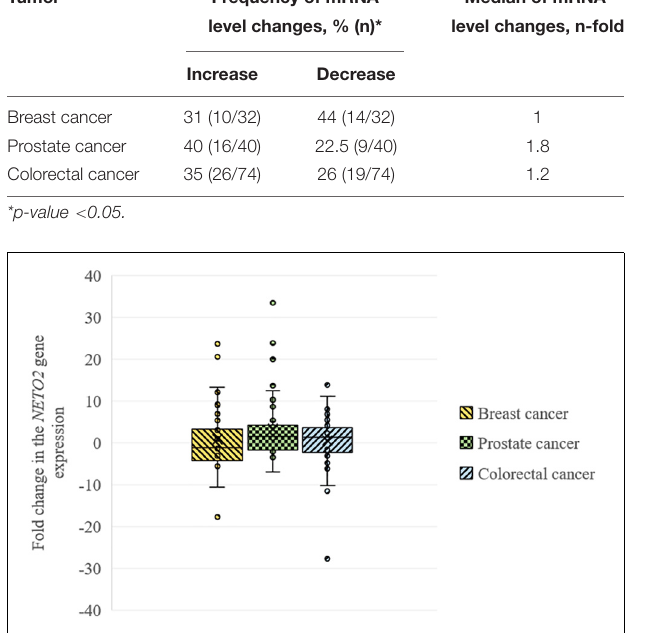
FIGURE 1 | Box plots for NETO2 expression changes in breast, prostate, and colorectal cancer.